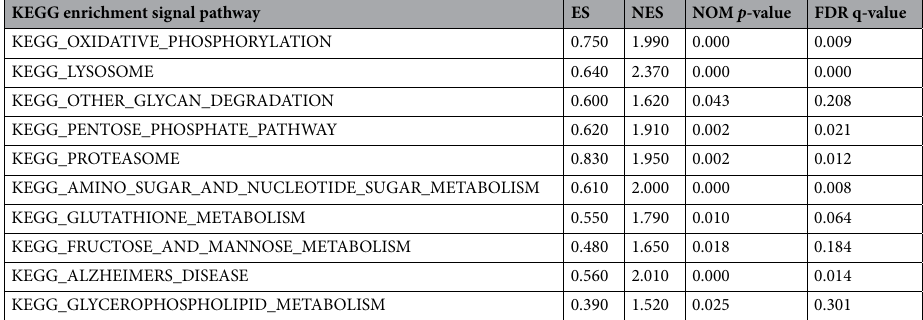
Table 6. The main enriched KEGG pathways of CTSA highexpression in GDC TCGA liver cancer cohort. ES enrichment score, NES normalized enrichment score, FDR false discovery